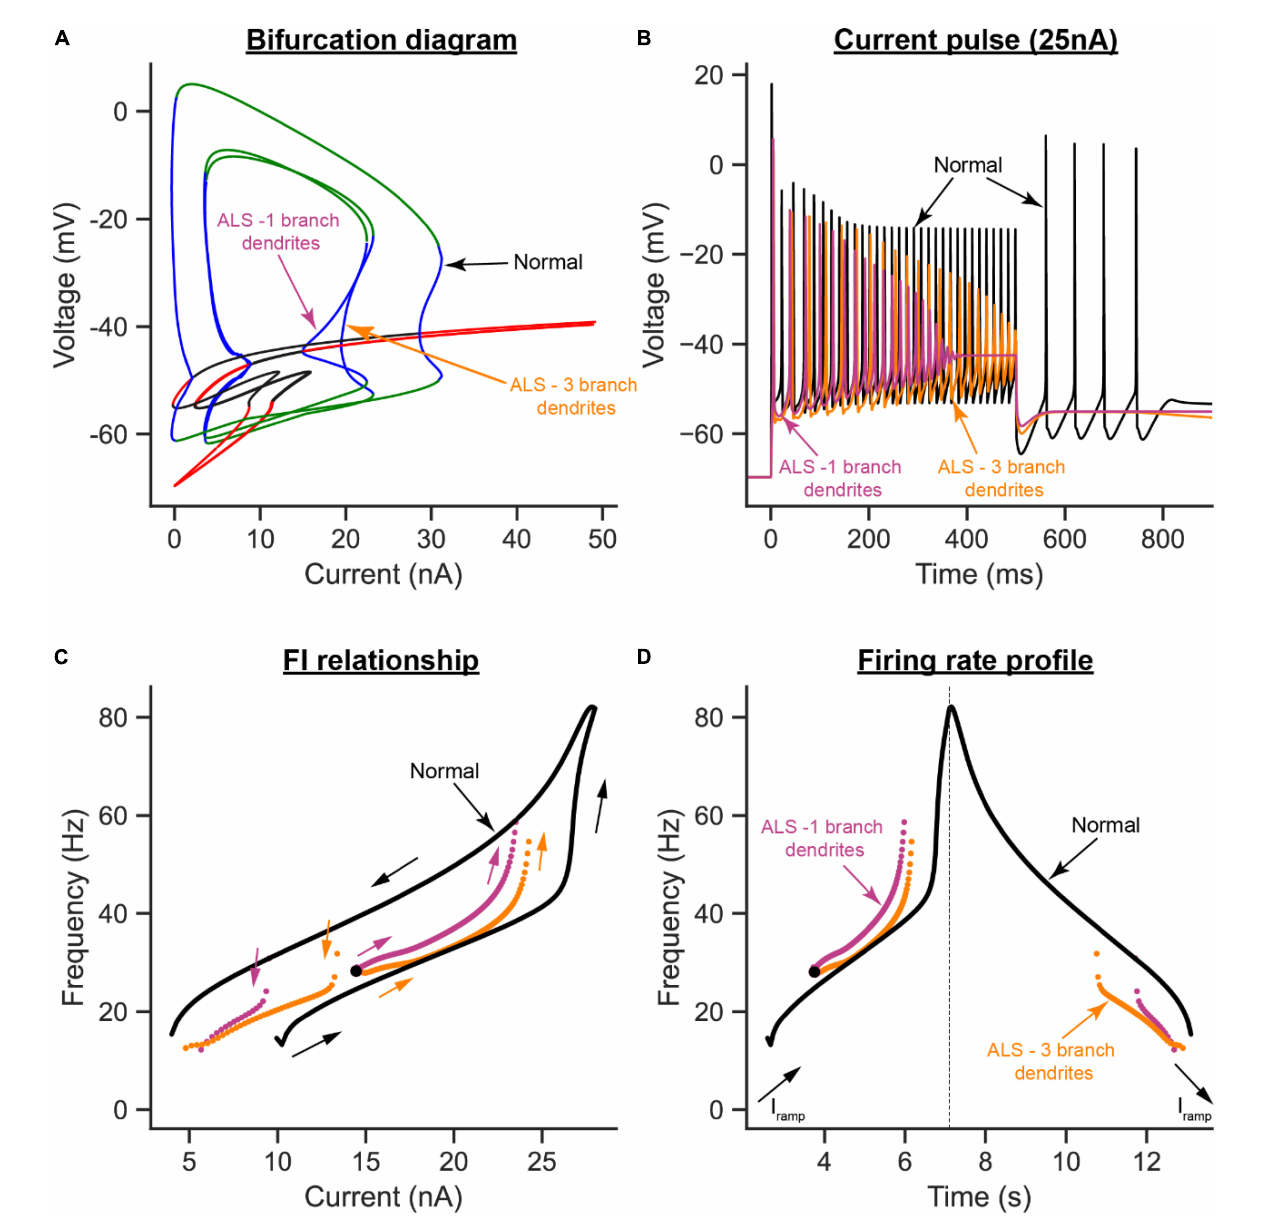
FIGURE8 The effects of dendritic overbranching in ALS on MN firing. (A) The V-I bifurcation diagrams, (B) cell firing on a 25 nA long current pulse, (C) F-I relationships during ramp current injection, and (D) firing rate profiles of the control model (normal condition, black traces) compared to the ALS models with dendritic area increased by 30% via a 1-branch dendrite (purple traces) or a 3-branch dendrite (orange